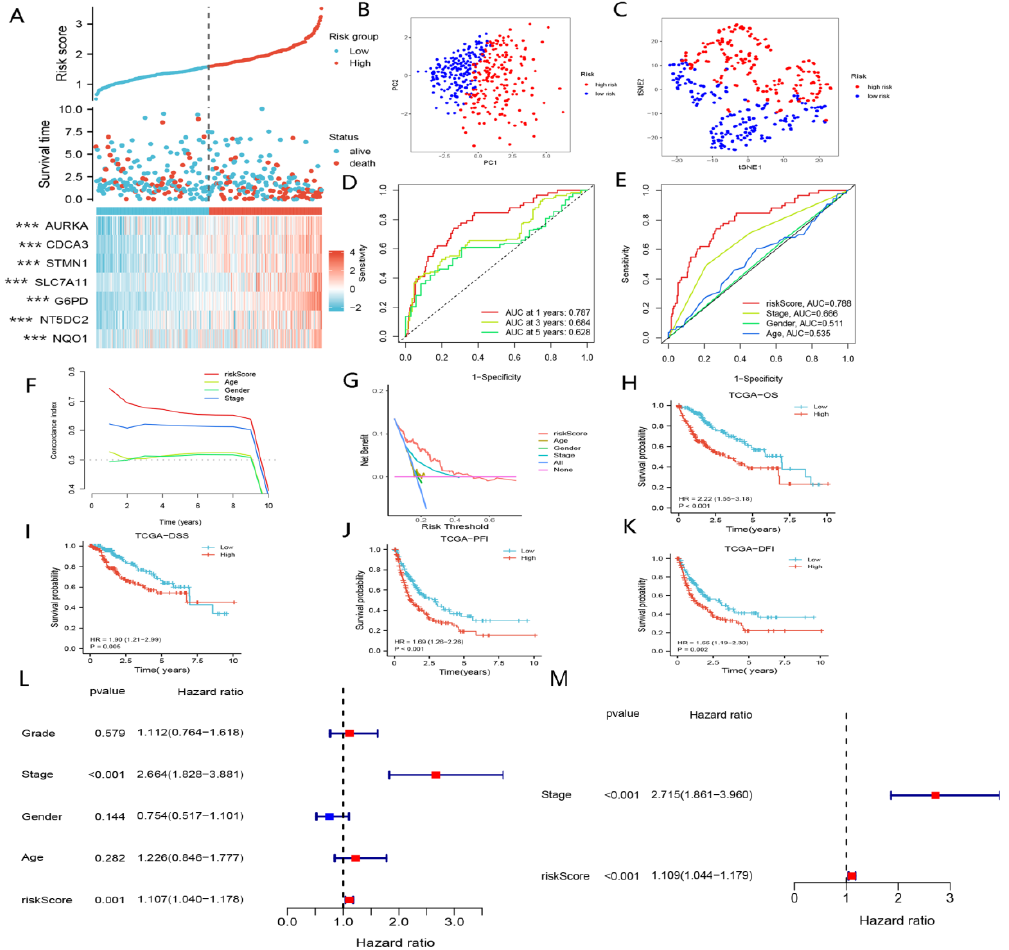
Figure 3. Construction of nFRGs in TCGA. ( A ) Risk score distribution map. ( B ) PCA plot. ( C ) t-NSE plot. ( D ) Time ROC curve of nFRGs. ( E ) ROC curve of nFRGs and other indicators. ( F ) C-index curve of risk score and other indicators. ( G ) DCA curve of risk score and other indicators. ( H ) KM curves of OS. ( I ) KM curves of DSS. ( J ) KM curves of DFI. ( K ) KM curves of PFI. ( L ) Univariate cox regression analysis of risk score and other indicators. ( M ) Multivariate cox regression analysis of risk score and TNM stage. (*** representing p < 0.001).